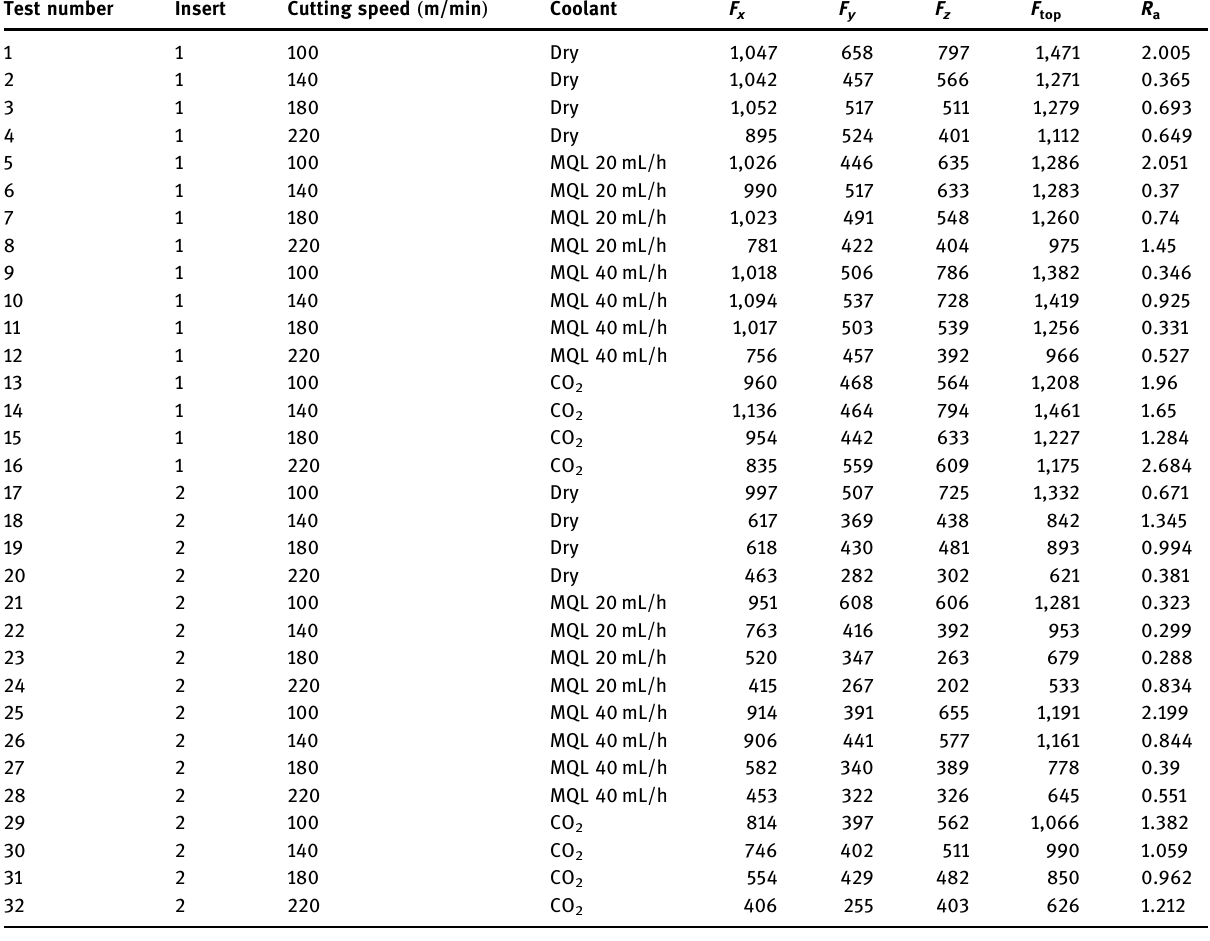
Table 3: Experimental results Test